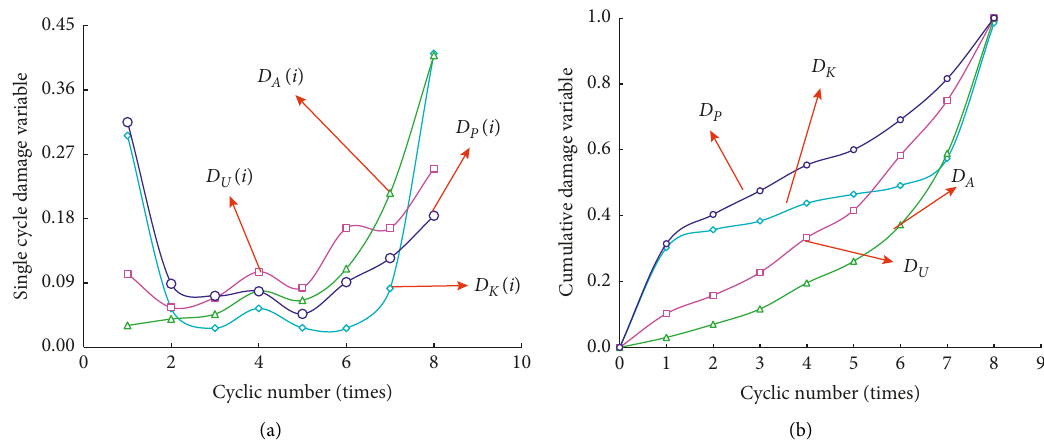
Figure 10: Damage variable curve based on different characteristics: (a) single cycle damage variable and (b) cumulative damage variable.